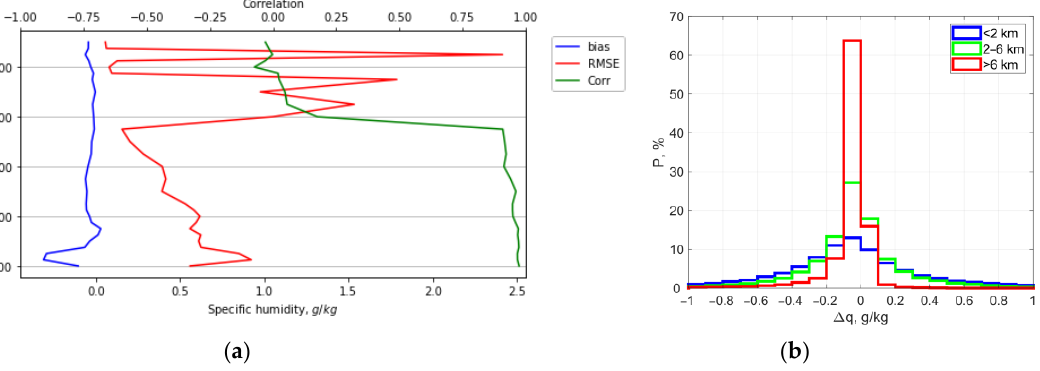
Figure 9. Vertical profiles of RMSE, Bias, and Corr for the values of specific humidity based on ERA5 [39] relative to RAOB [25] data for 2016–2020 ( a ) and the corresponding distribution of de- viations Δ q ( b ) for the coordinates of the specified aerological stations.